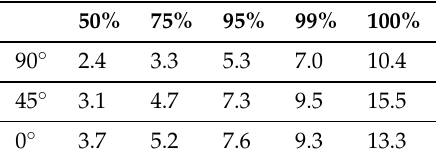
Table 5. Percentiles of σ r (mm) for elevations 90 ◦ , 45 ◦ , and 0 ◦ .